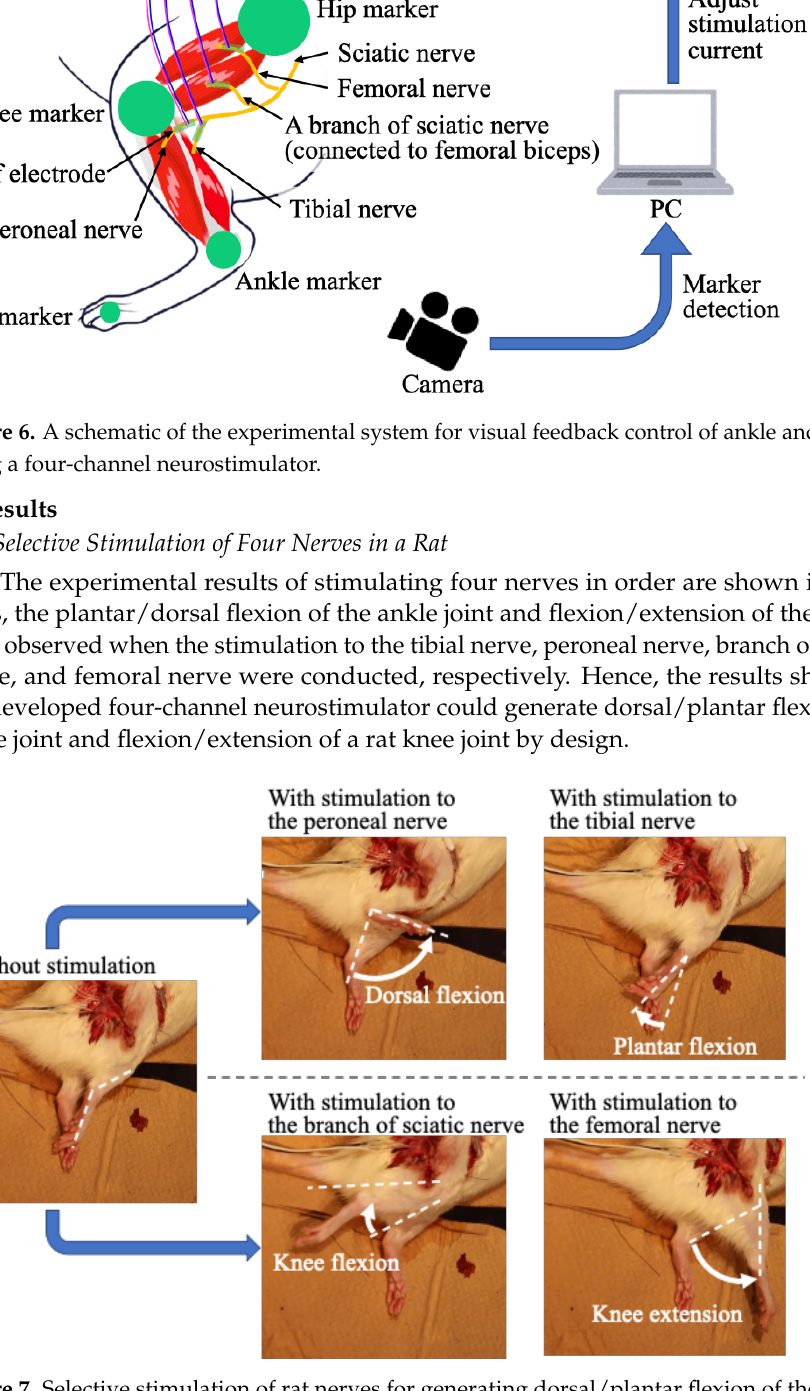
Figure 7. Selective stimulation of rat nerves for generating dorsal/plantar flexion of the ankle joint and flexion/extension of the knee